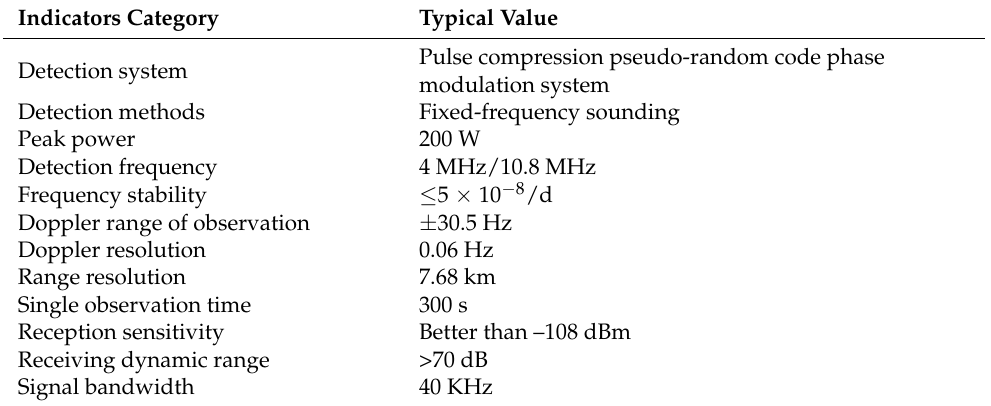
Table 1. Technical parameters of the ionospheric sounding